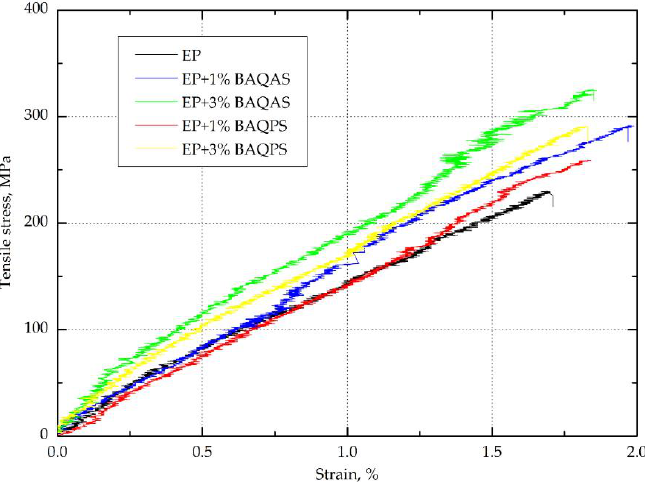
Figure 5. Representative stress-strain curves from the tensile test for the tested Kevlar-reinforced composites.